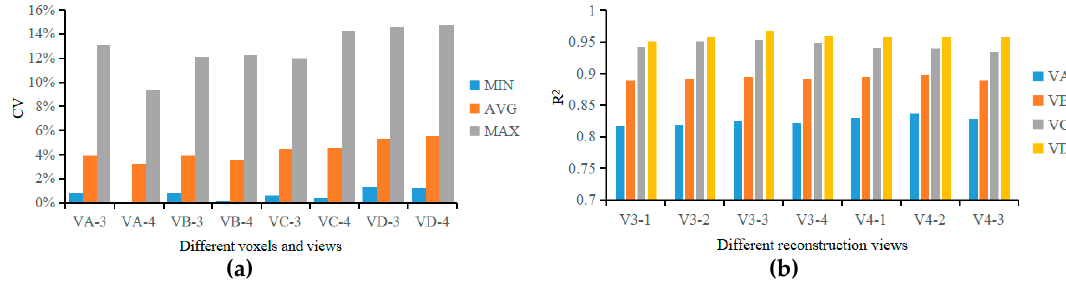
Figure 11. Performance parameters of canopy volume measurement. ( a ) CV of canopy volume, ( b ) R 2 for the calculated and measured values of canopy volume.